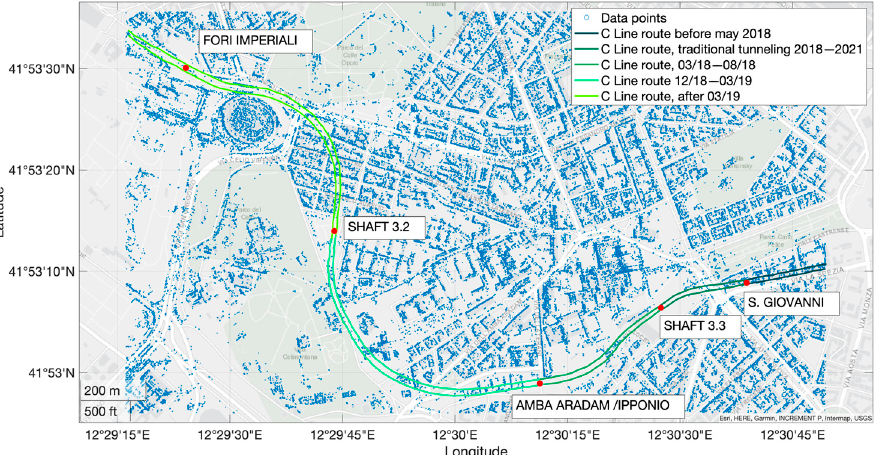
Figure 1. Map showing the T3 section of the Line C subway and the numerosity of points obtained by satellite interferometry over the analyzed urban area of Rome (Italy).